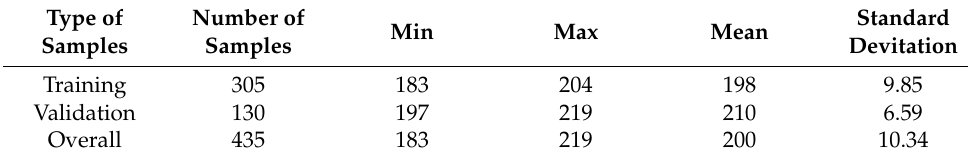
Table 7. Wheat growth cycle value characterization